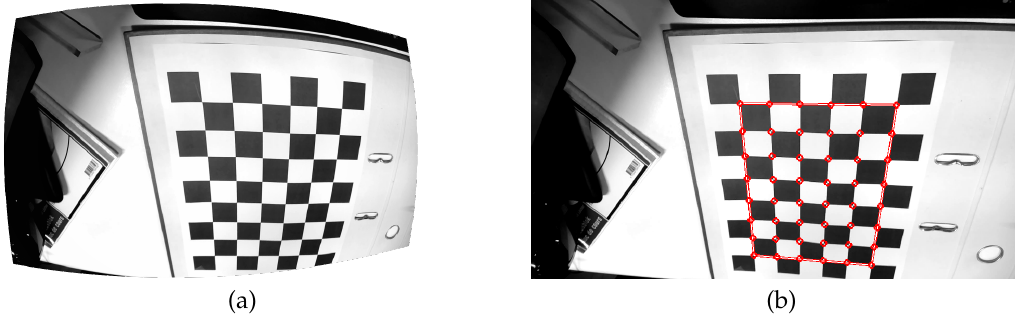
Figure 1. Example of the detection of a checkerboard. A radially distorted input image ( a ) and the undistorted image with the detected points highlighted in red ( b